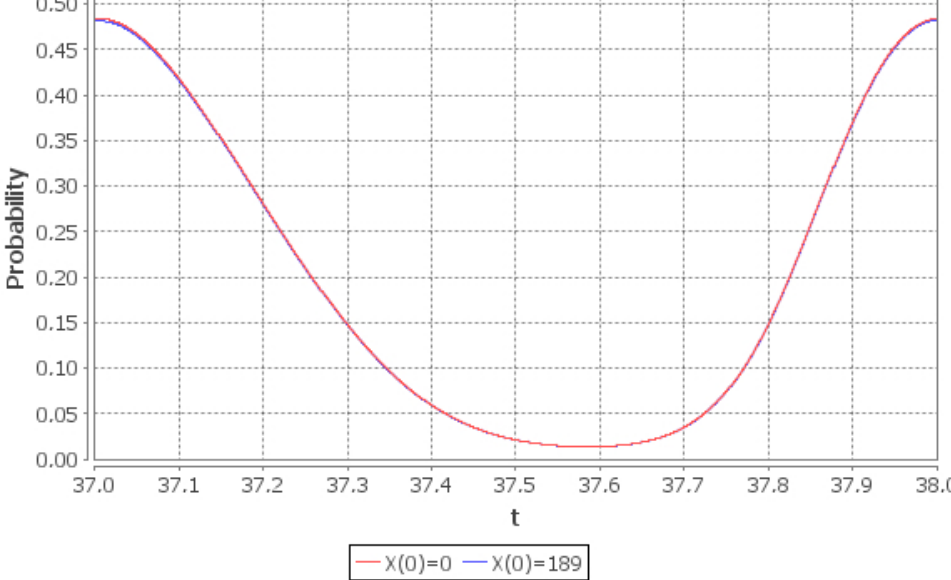
Figure 2. Limiting probability p 0 ( t ) of the empty queue given two different initial conditions: p 0 ( 0 ) = 1 ( red line ), p 189 ( 0 ) = 1 ( blue line